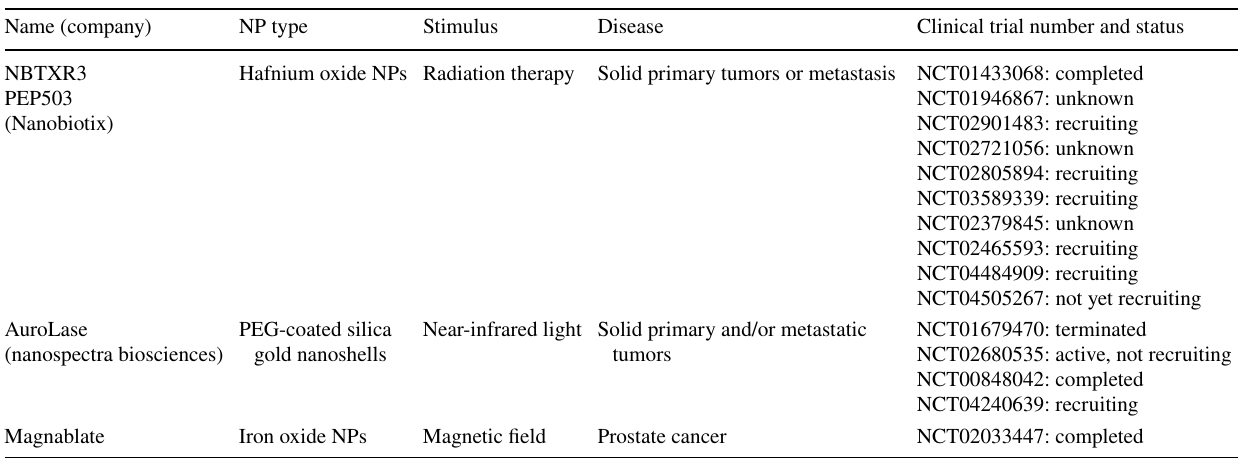
Table 1 Clinical trials involving remotely triggered NPs for cancer cell death. Adapted from Ref. [208] Name